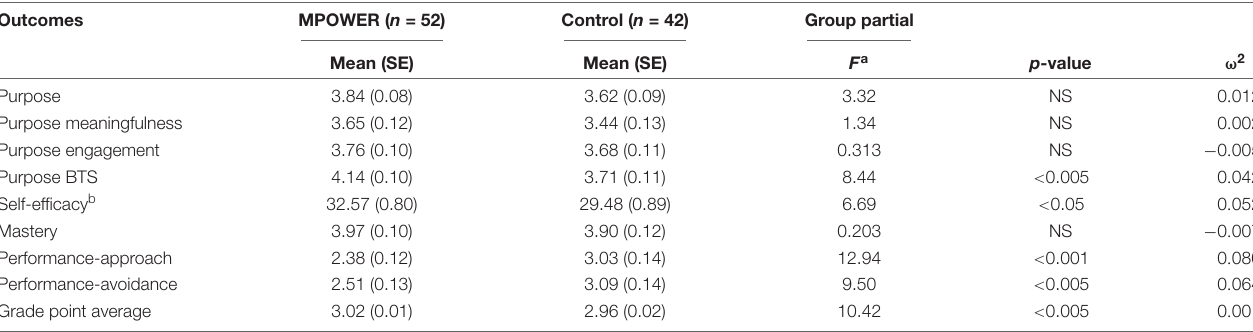
TABLE 3 | ANCOVA results among participants’ post-test